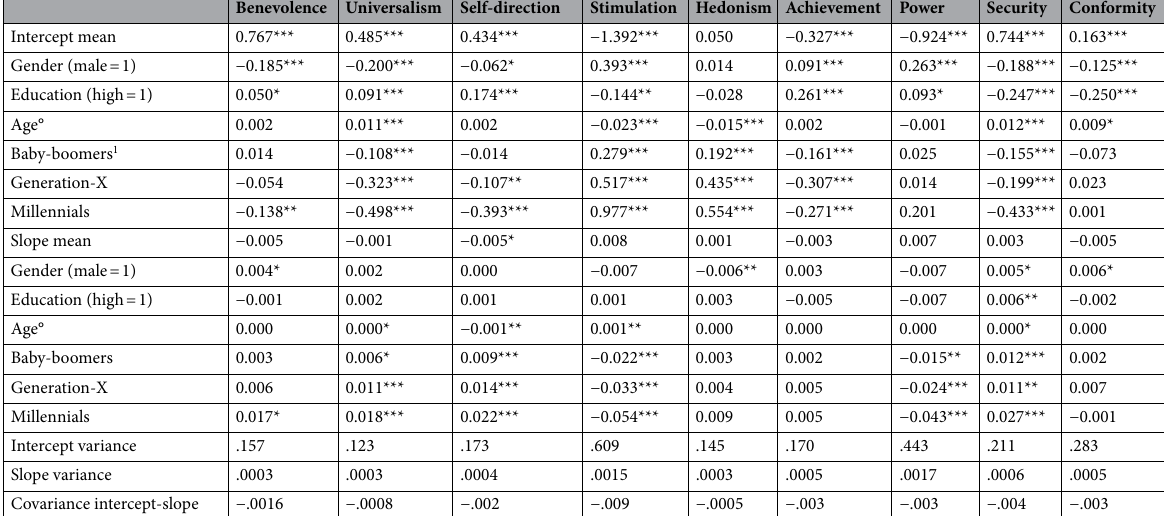
Table 4. Growth curves per value; no change and linear change; SEM approach lavaan (R; Rosseel, 2012). Associated p -values and confidence intervals can be found in the supplementary materials (SI 11, Table 6.1— 6.3). * p < .05; ** p < .01; *** p < .001. 1 Silent-generation is the reference category. ° mean-centered within generation (i.e., age means age difference within